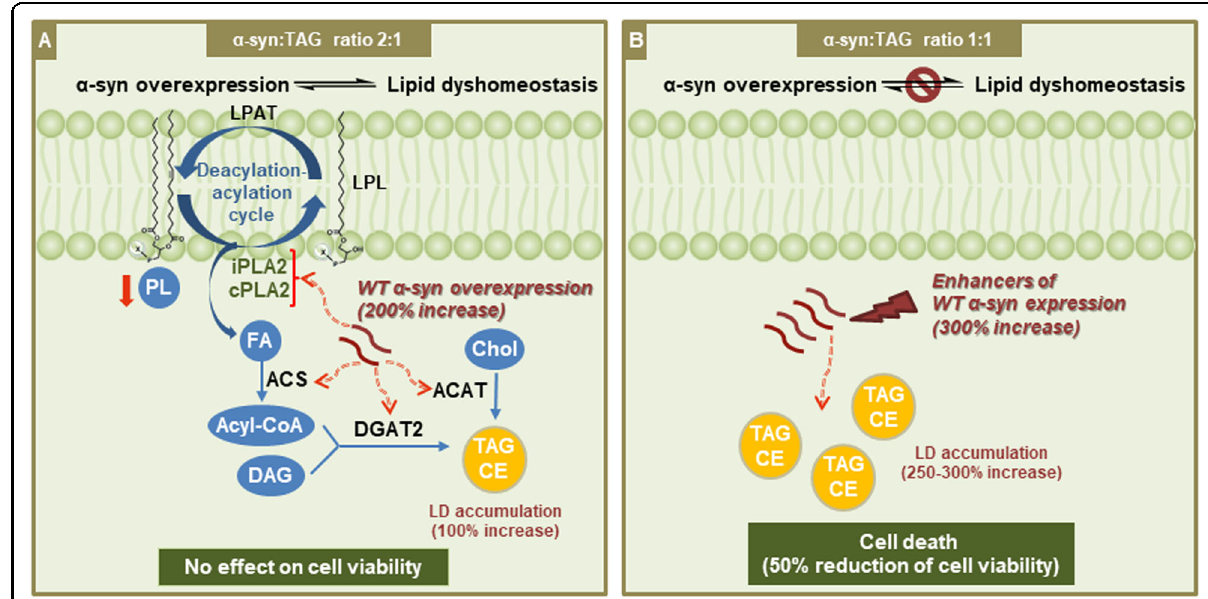
Fig. 8 Schematic diagram showing impairment of lipid homeostasis triggered by α -syn and implications for cellular fate. A Imbalance of the PL deacylation-acylation cycle due to PLA2 activation mediated by α -syn overexpression is responsible for neutral lipid acylation and the consequent LD accumulation ( α -syn:TAG ratio 2:1), with no changes in cell viability. B Under conditions of enhancement of α -syn expression, LD accumulation is exacerbated ( α -syn:TAG ratio 1:1) and cell death is